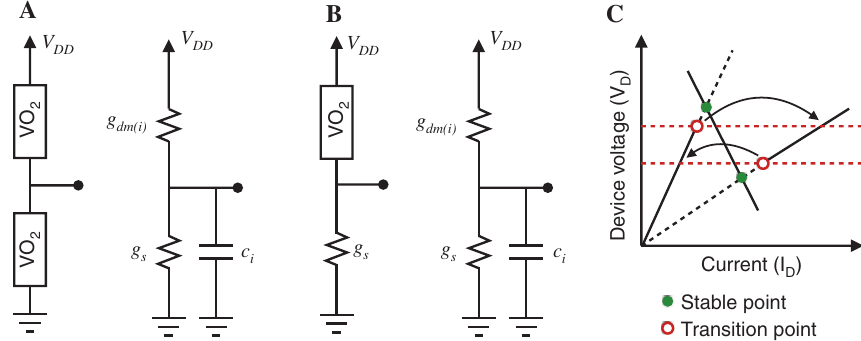
Figure 1: (A) D-D oscillator circuit configuration and its equivalent circuit. (B) D-R oscillator circuit configuration and its equivalent circuit. (C) Load line graph for the D-R circuit and the region of operation of D-R oscillator. When the stable points (green filled points) are outside the region of operation, the system shows